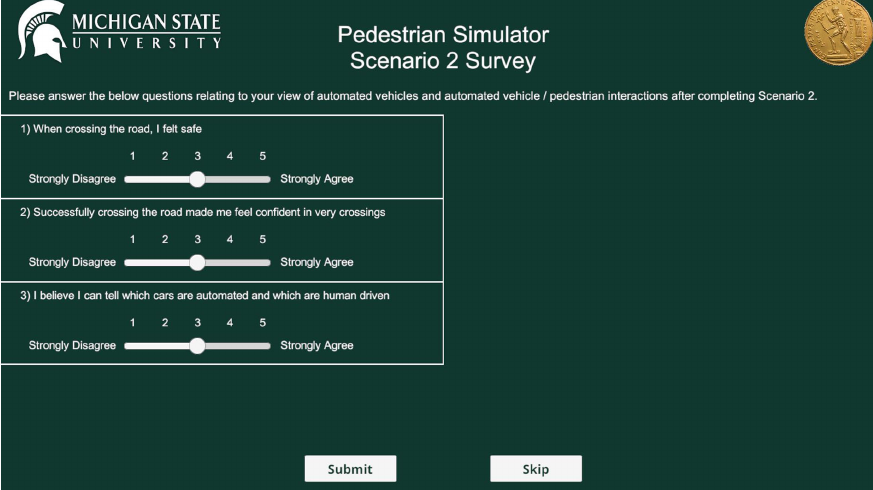
Figure 4. This survey appears after a user completes the second